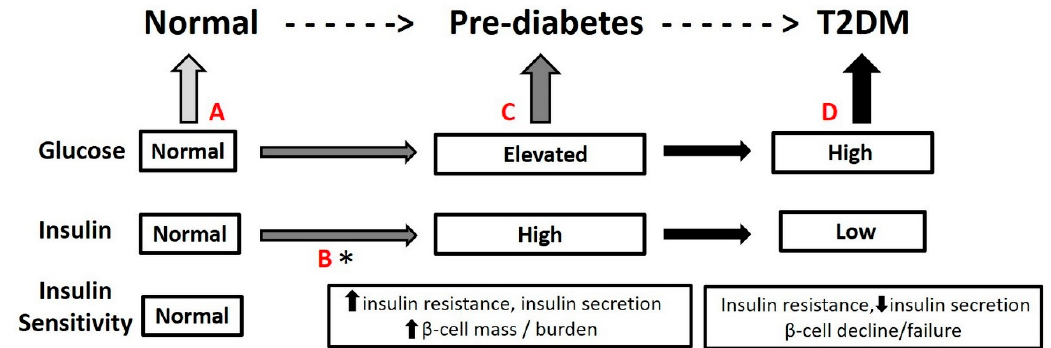
Figure 1. Path to Diabetes/T2DM: A . normal, non-disease/diabetes state (based on fasting glucose 70–99 mg/dL). B . declining insulin sensitivity/increasing insulin resistance, and increasing concentrations of insulin (hyperinsulinemia) to maintain normal glucose: Opportunity * for early detection and intervention to restore normal insulin sensitivity and decrease beta cell burden. C . pre-diabetes identified (fasting glucose 100–125 mg/dL, [1], hyperinsulinemia insufficient to overcome insulin resistance. Diet and lifestyle intervention prescribed. D . T2DM diagnosed (fasting glucose ≥ 126 mg/dL or 2-h post glucose ≥ 140 mg/dL, [1], diet and lifestyle and medications prescribed.